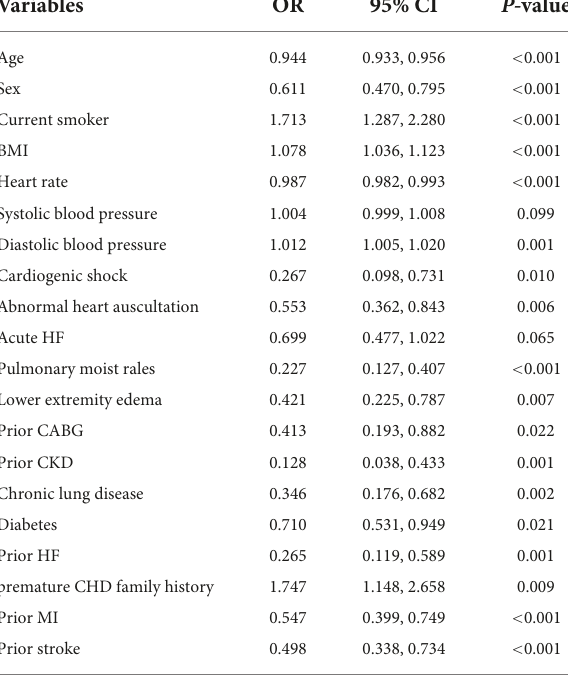
TABLE 5 Univariate analysis of whether NSTEMI patients undergo CAG.